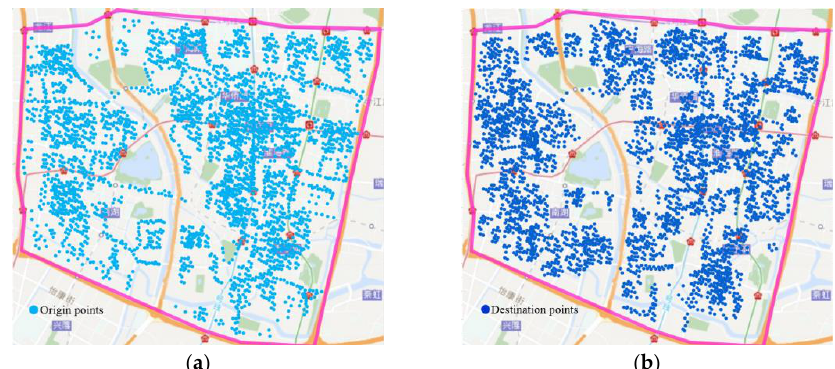
Figure A2. Distribution of starting and arriving points. ( a ) Distribution of origin points. ( b ) Distribution of destination points.